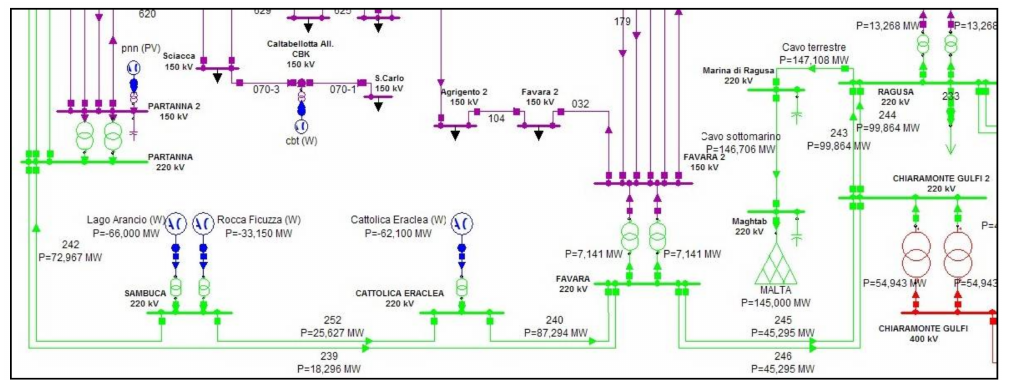
Figure 4. Scenario 2—Power flows on the portion of the network near the submarine interconnection connected to Ragusa